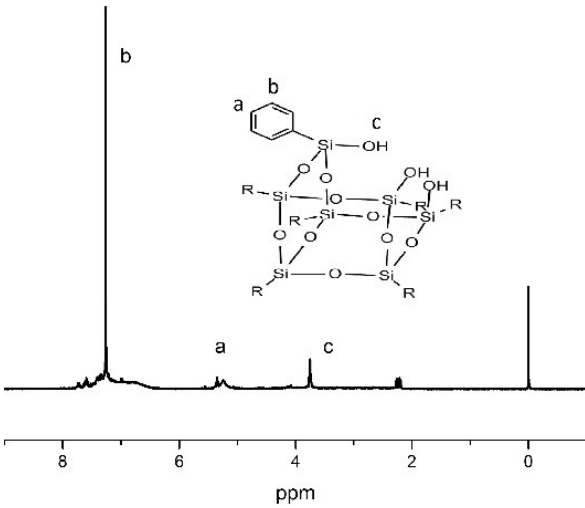
Figure 5: 1 H NMR spectrum of heptamertic phenyl